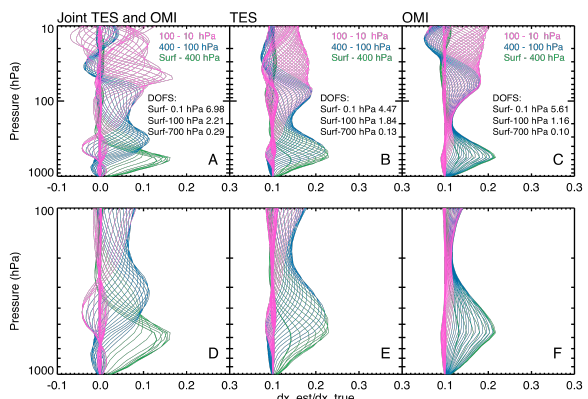
Figure 2 . Examples of averaging kernels for the measurement over Wallops Island, Virginia, 2 Fig. 2. Examples of averaging kernels for the measurement over USA on October 2 nd , 2007: (A) Joint TES and OMI measurement; (B) TES measurement; (C) 3 Wallops Island, Virginia, USA, on 2 October 2007: (A) Joint TES OMI measurement; (D, E, F) zoom-in averaging kernels from surface to 100 hPa. In each 4 and OMI measurement; (B) TES measurement; (C) OMI measure- panel, averaging kernels in three altitude ranges are shown in color curves: surface to 400 hPa 5 ment; (D, E, F) zoom-in averaging kernels from surface to 100hPa. in green; 400 to 100 hPa in blue; 100 to 10 hPa in magenta. For Joint TES/OMI 6 In each panel, averaging kernels in three altitude ranges are shown measurements, TES alone and OMI alone, DOFS in the altitude of surface to 700 hPa is 0.48, 7 in color curves: surface to 400hPa in green; 400 to 100hPa in 0.38, 0.19 respectively; in the altitude of surface to 100 hPa is 2.05, 1.78, 1.11 respectively; in 8 blue; and 100 to 10hPa in magenta. For Joint TES/OMI measure- the altitude of surface to 0.1 hPa is 6.64, 4.29, 5.41 respectively. 9 ments, TES alone and OMI alone, DOFS in the altitude of surface to 700hPa is 0.48, 0.38, 0.19, respectively; in the altitude of surface to 100 hPa is 2.05, 1.78, 1.11, respectively; and in the altitude of surface to 0.1hPa is 6.64, 4.29, 5.41,